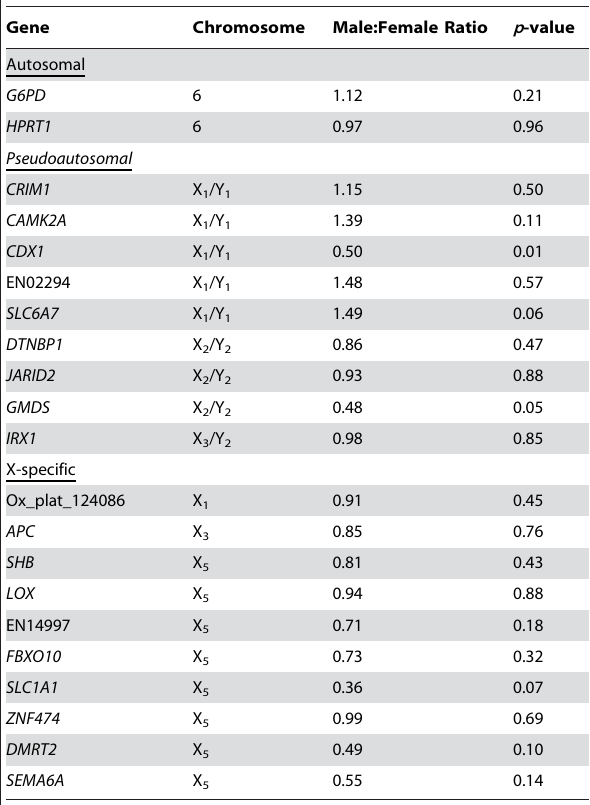
Table 2. Male:female ratio for expression of platypus X genes in fibroblast cells normalized to the autosomal ACTB housekeeping gene.